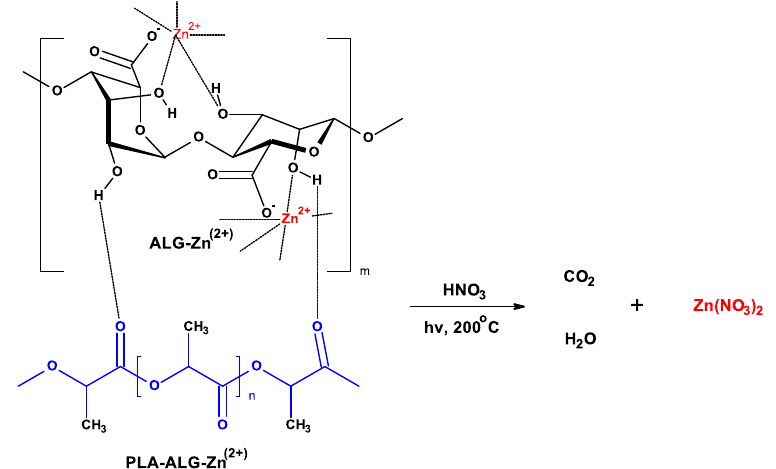
Figure 3. Mineralization of PLA-Alg-Zn (2+) .